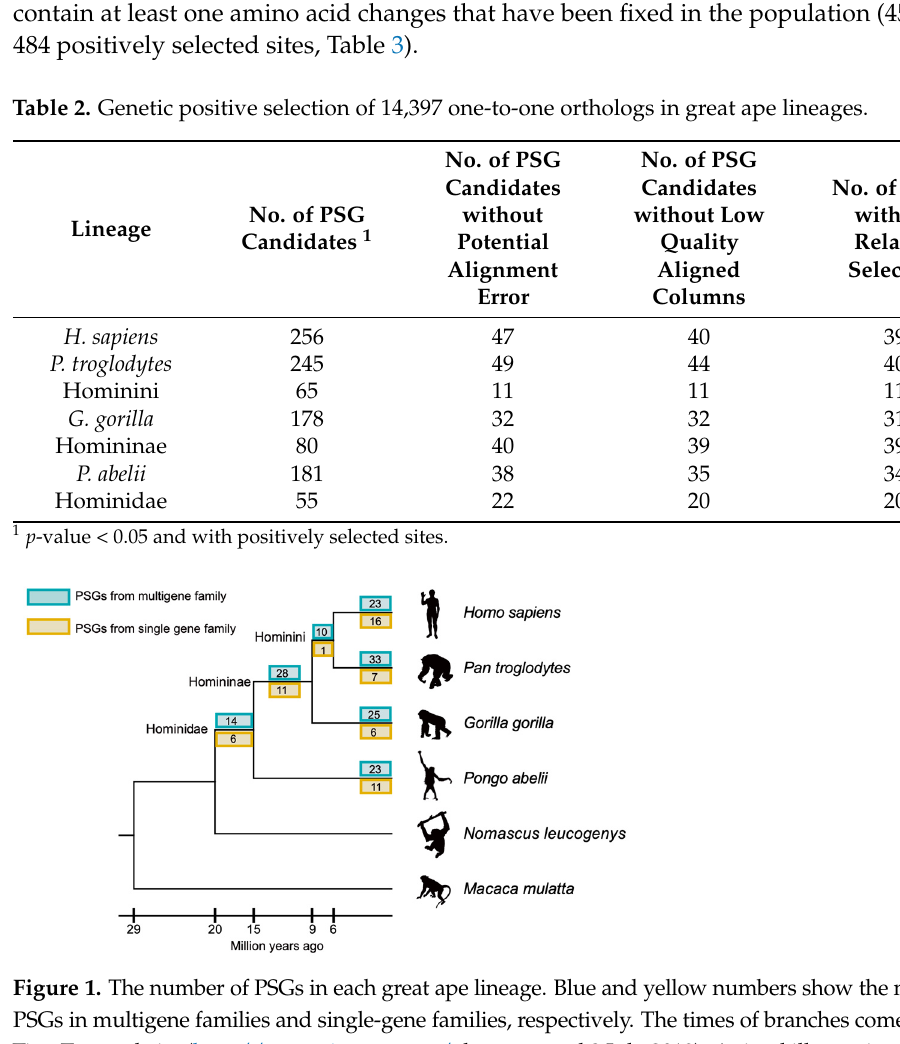
Table 2. Genetic positive selection of 14,397 one-to-one orthologs in great ape lineages.